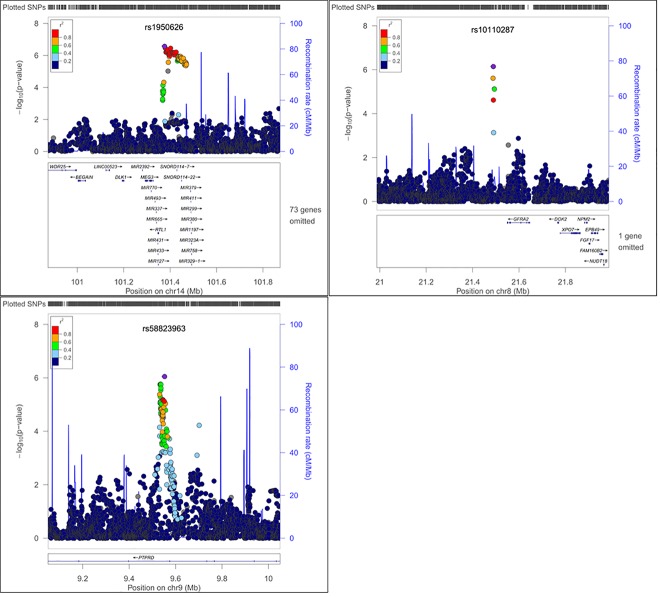
Regional association plots showing–log10(p-values) against base-pair position for Hispanic (HP) women considering grade 0 vs. 1–3 analyses.